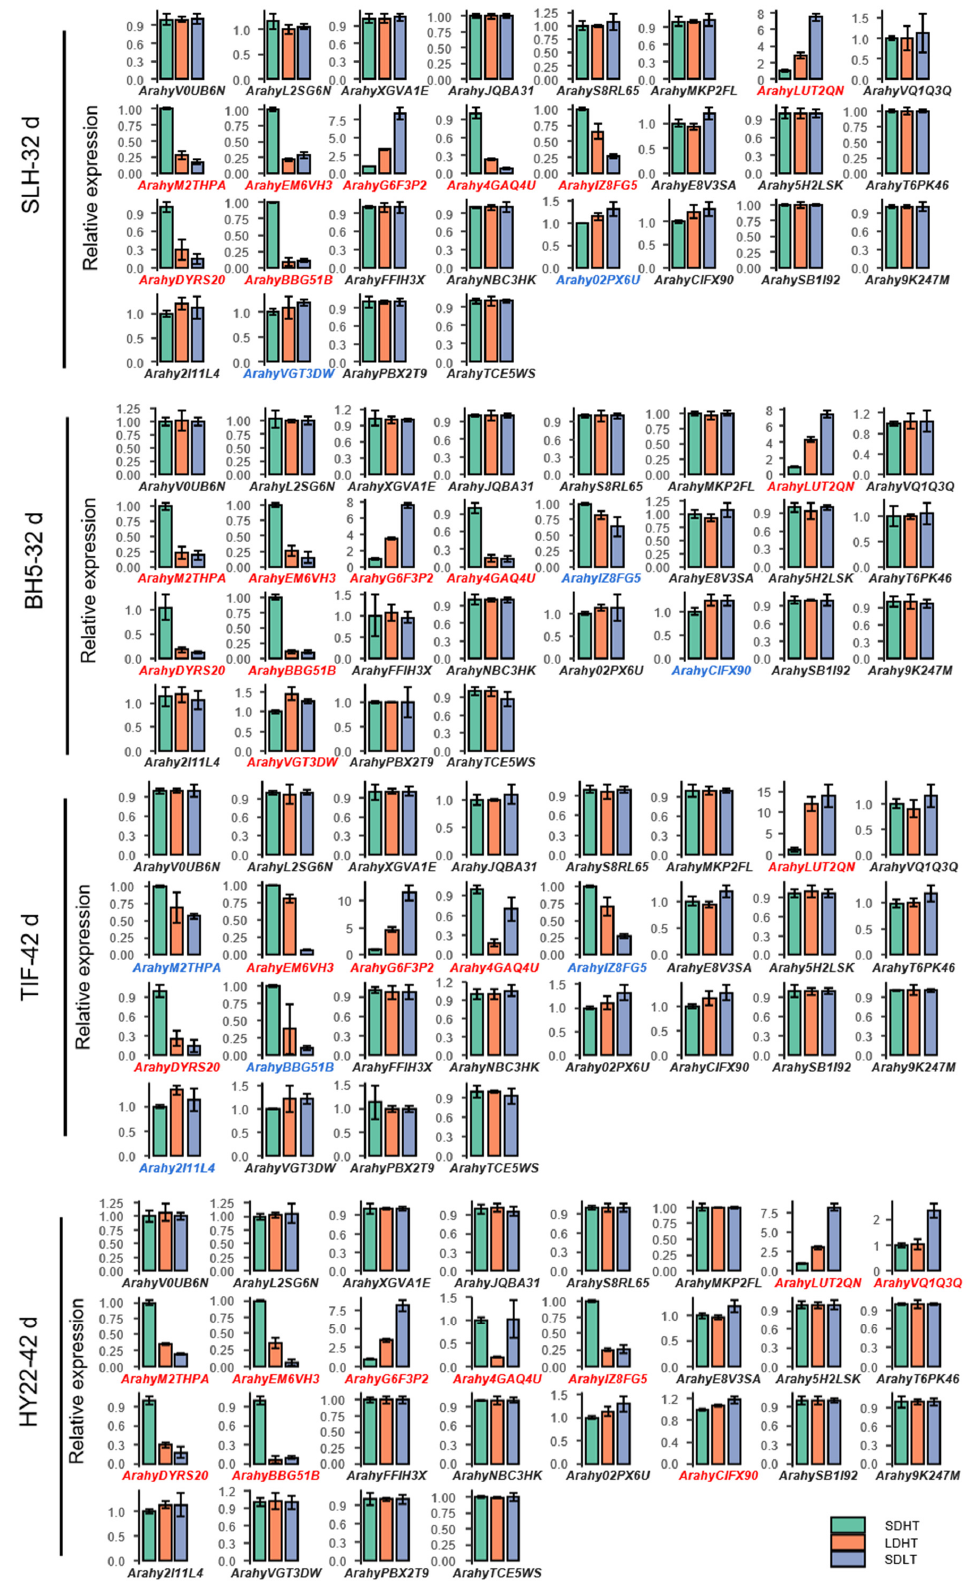
Figure 9. PEBP gene expression patterns in different peanut genotypes with different flowering times. The short-day high temperature group (SDHT) was compared with the long-day high